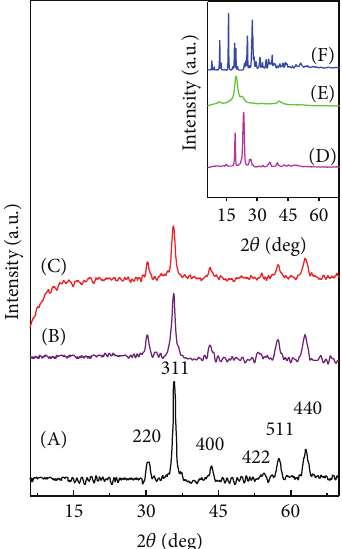
Figure 1: XRD patterns of FNPs (A), FPVAG (B), and FPEGG (C). The inset shows the XRD patterns of pure PEG (D), pure PVA (E), andpureGA(F).FPEGG:ironoxidecoatedwithpolyethyleneglycol and gallic acid, FPVAG: iron oxide coated with polyvinyl alcohol and gallic acid, PEG: pure polyethylene glycol, PVA: pure polyvinyl alcohol, and GA: pure drug gallic acid.